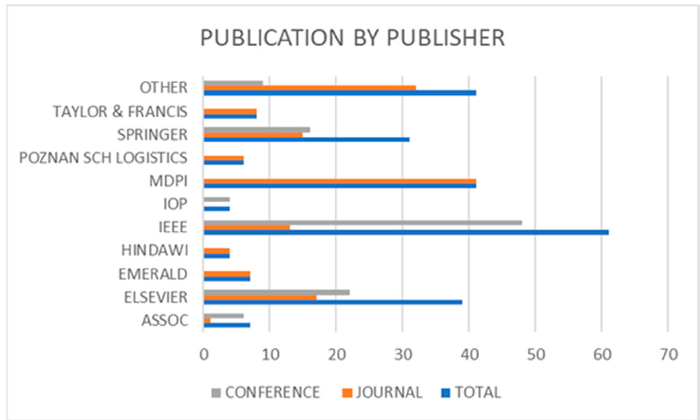
Figure 5. Publication by the publisher.